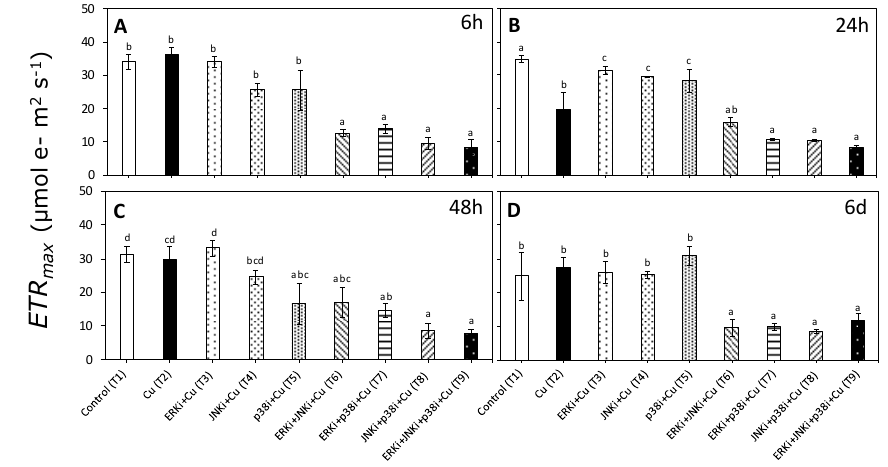
Figure 4. Maximal electron transport rate (ETR max ) in U. compressa under copper and/or exposure to MAPK inhibitors. Treatments: T1—control only with seawater; T2—copper only exposure as 10 µM CuSO 4 (Cu); T3—copper + 5 µM MAPK ERK inhibitor PD98059 (Cu + ERKi); T4—copper + 5 µM MAPK JNK inhibitor SP600125 (Cu + JNKi); T5—copper + MAPK p38 inhibitor SB203580 (Cu + p38i); T6—Cu + ERKi + JNKi; T7—Cu + ERKi + p38i; T8—Cu + p38i + JNKi; and T9)—Cu + ERKi + JNKi + p38i. Samples were analyzed after ( A ) 6 h, ( B ) 24 h, ( C ) 48 h, and ( D ) 6 d of treatment. Different letters within each graph represent significant differences at the 95% confidence interval ( p < 0.05). Plots are mean ± SE ( n = 3).